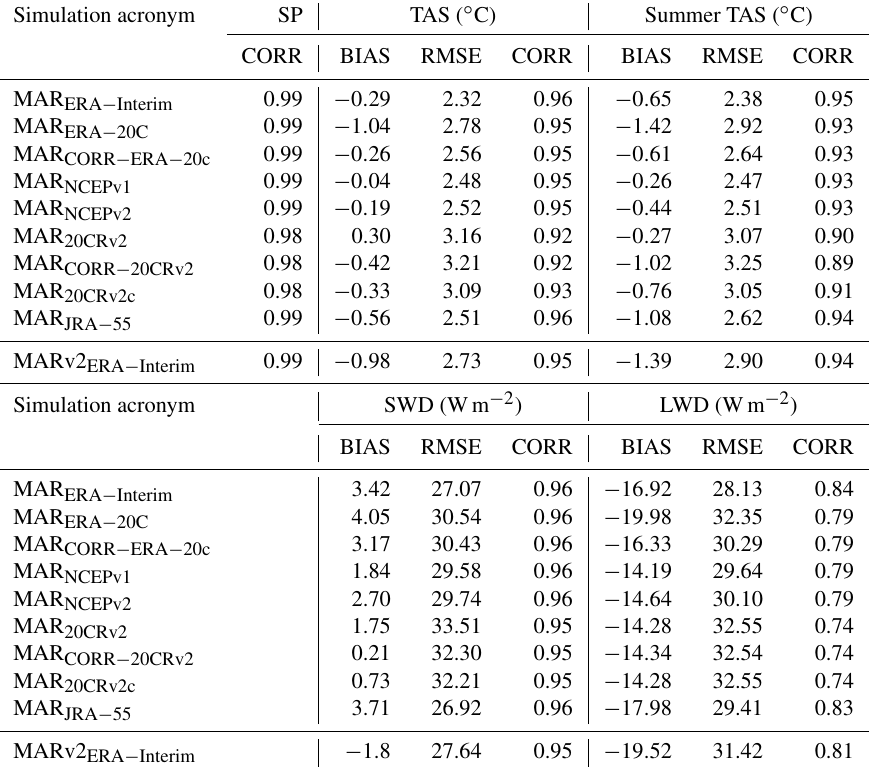
Table 2. Mean correlation, bias, RMSE and correlation over the 12 AWSs listed in Table S1 of the Supplement between MAR forced by the different reanalyses and daily observations from the PROMICE network over 2008–2010. Statistics are given for the surface pressure (SP), near-surface temperature (TAS) over the entire year and for the summer months only (for JJA; Summer TAS), shortwave downward flux (SWD) and longwave downward flux